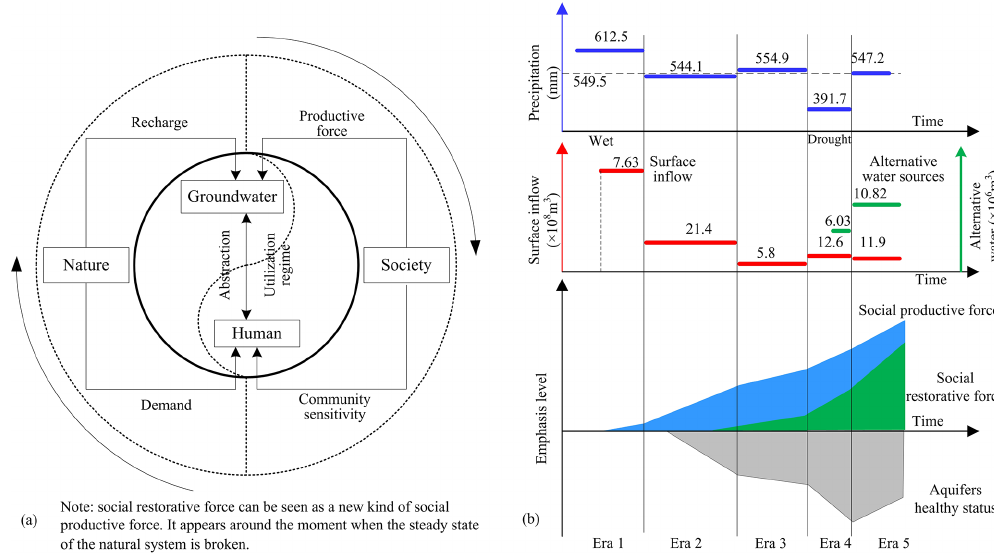
Figure 4. (a) Taiji–Tire model representation of the interactions of the human–groundwater system; (b) changes in natural variability (pre- cipitation and surface inflow), social productive forces in Cangzhou through five eras (emphasis level used in relation to the vertical axis refers to the degree of increase in the variables described in the